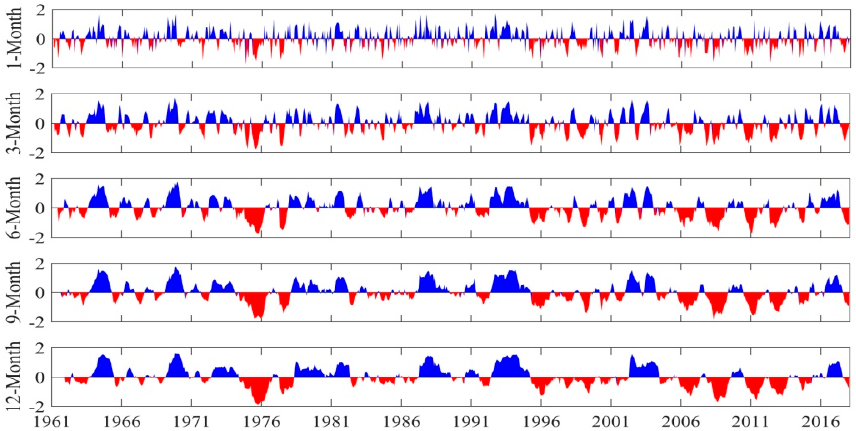
Figure 3. The 1-, 3-, 6-, 9-, and 12-month SPEI based on monthly averages in CA from 1961 to 2017.